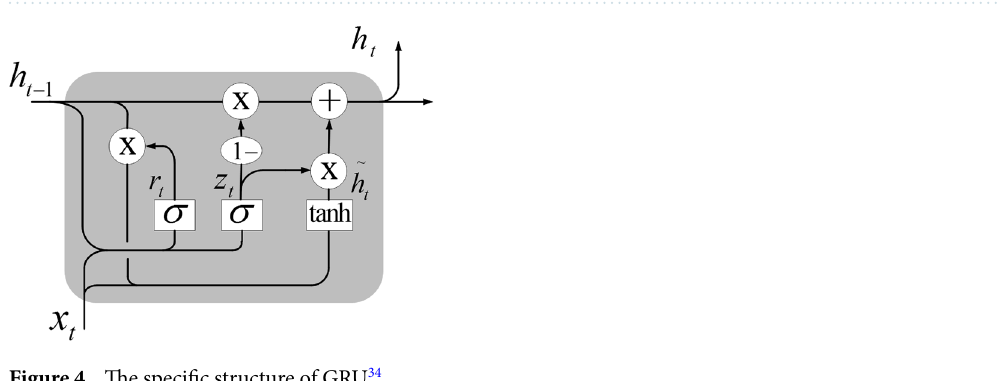
Figure 4. The specific structure of GRU 34